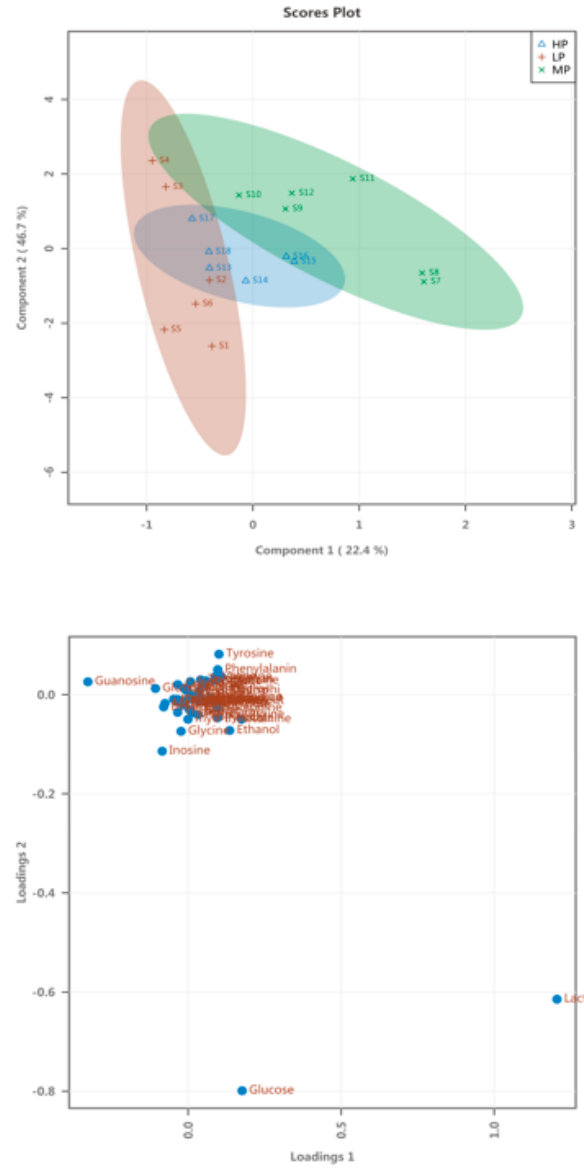
Figure 8. PLS-DA score plots and loading plots of serum. ( a ) PLS-DA score plots; ( b ) PLS-DA Figure 8. PLS ‐ DA score plots and loading plots of serum. ( a ) PLS ‐ DA score plots; ( b ) PLS ‐ DA loading loading plots.